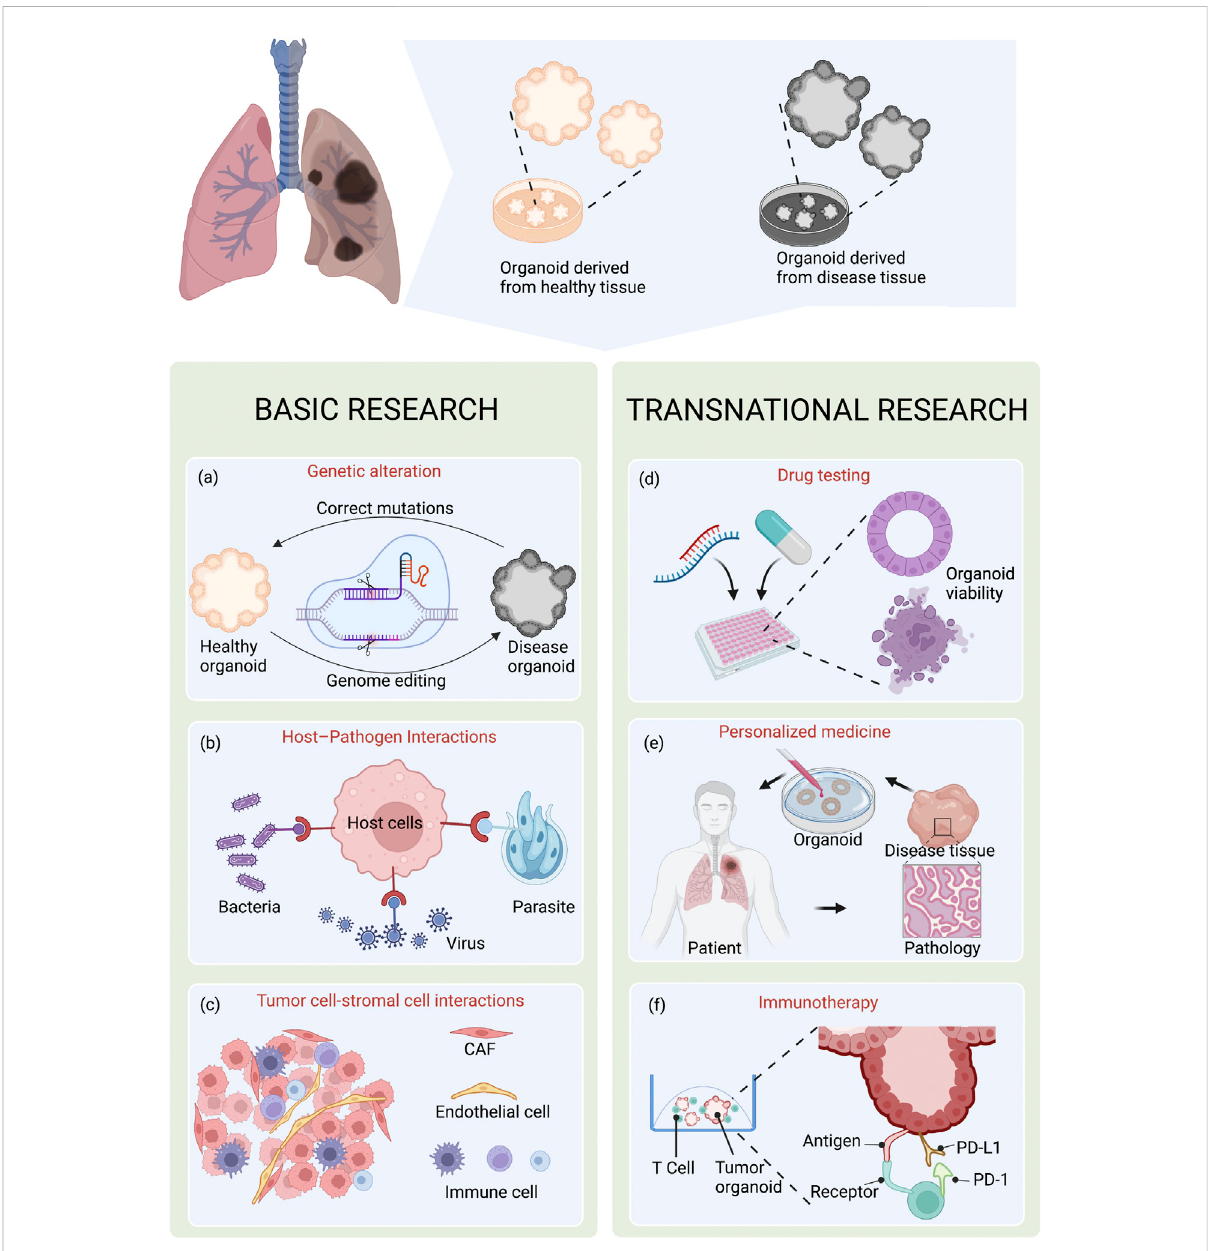
3D organoid cultures have great value in basic and translational research. (A) Combined with gene editing technique CRISPR/Cas9, organoid system provides ideal models for investigating genetic diseases caused by genetic alteration. (B,C) Organoid technology provides in vitro models for studying host-pathogen interactions and tumor cell-stromal cell interactions. (D,E) At the preclinical stage, organoids can also be used in drug development, including high-throughput drug screening and personalized drug. (F) In addition, 3D co-culture of tumor cells and T cells have the potential to study tumor immumotherapy. Created with